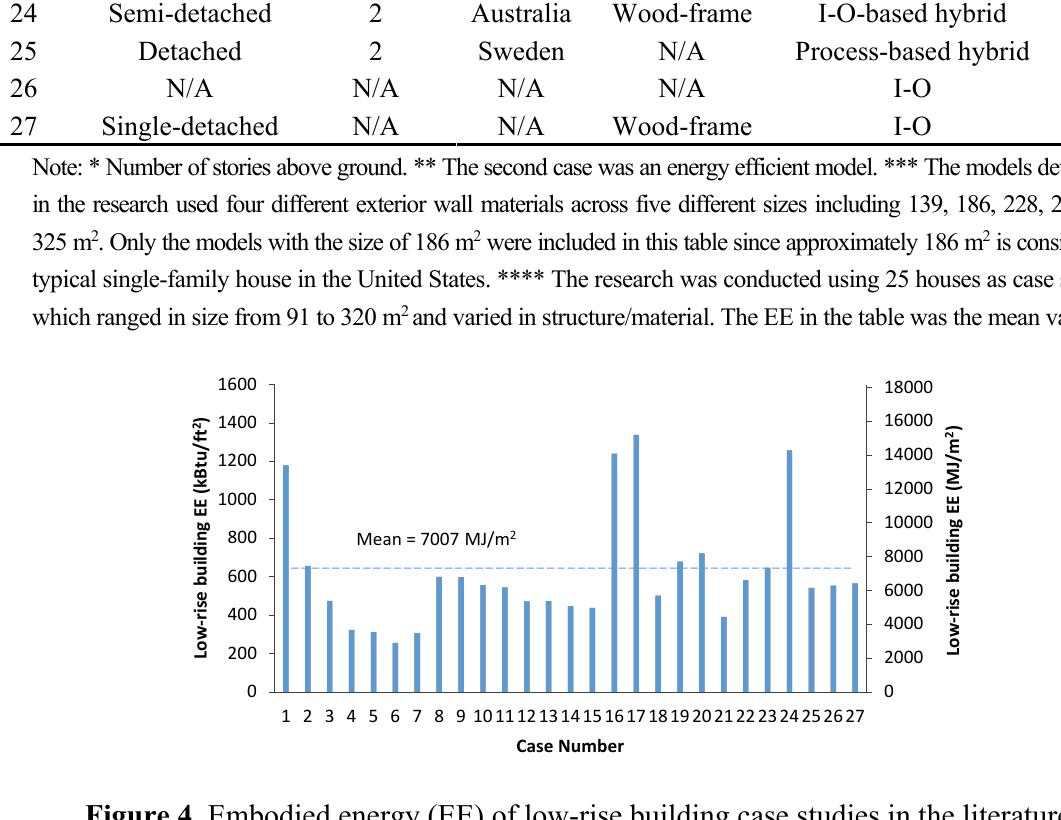
Figure 4. Embodied energy (EE) of low-rise building case studies in the literature.